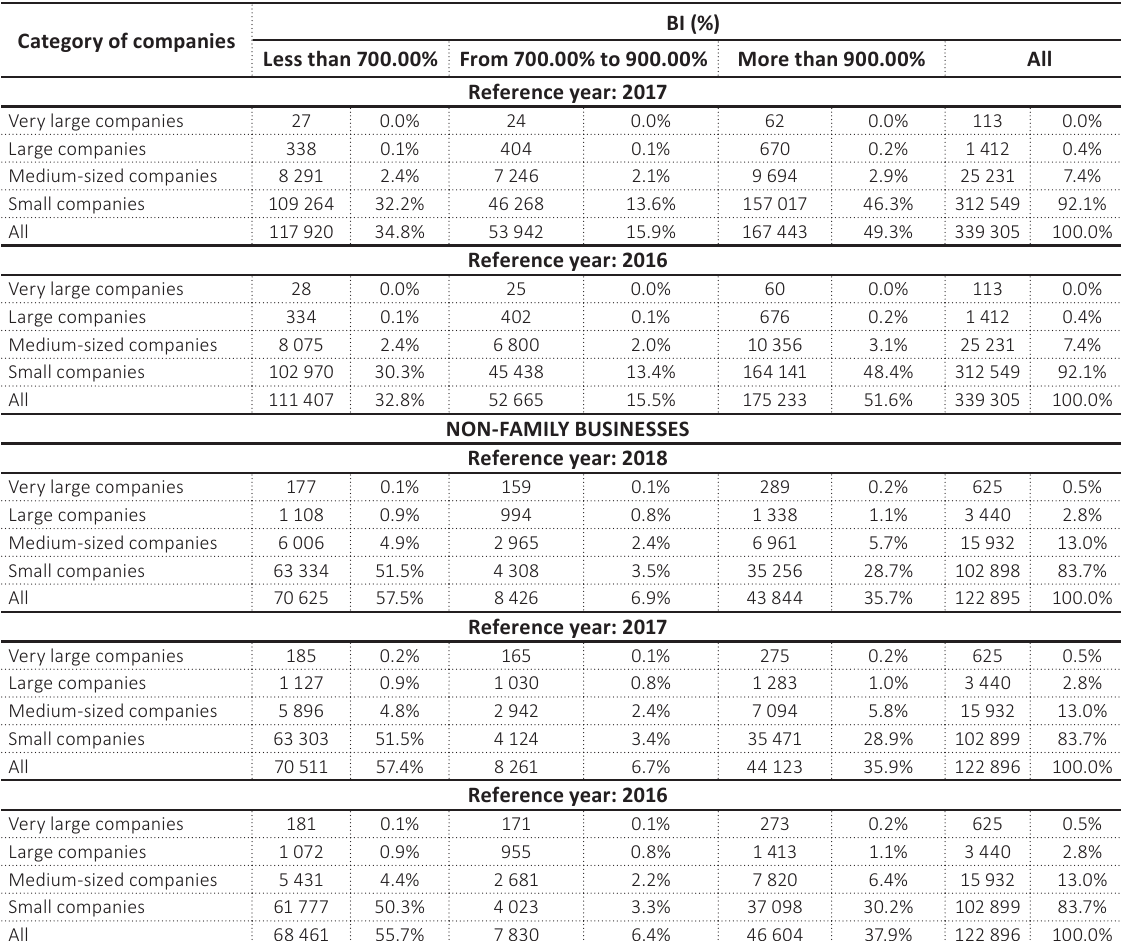
Table 6 (cont.). Bankruptcy Index values of the total of active Hungarian companies grouped by size and differentiated by